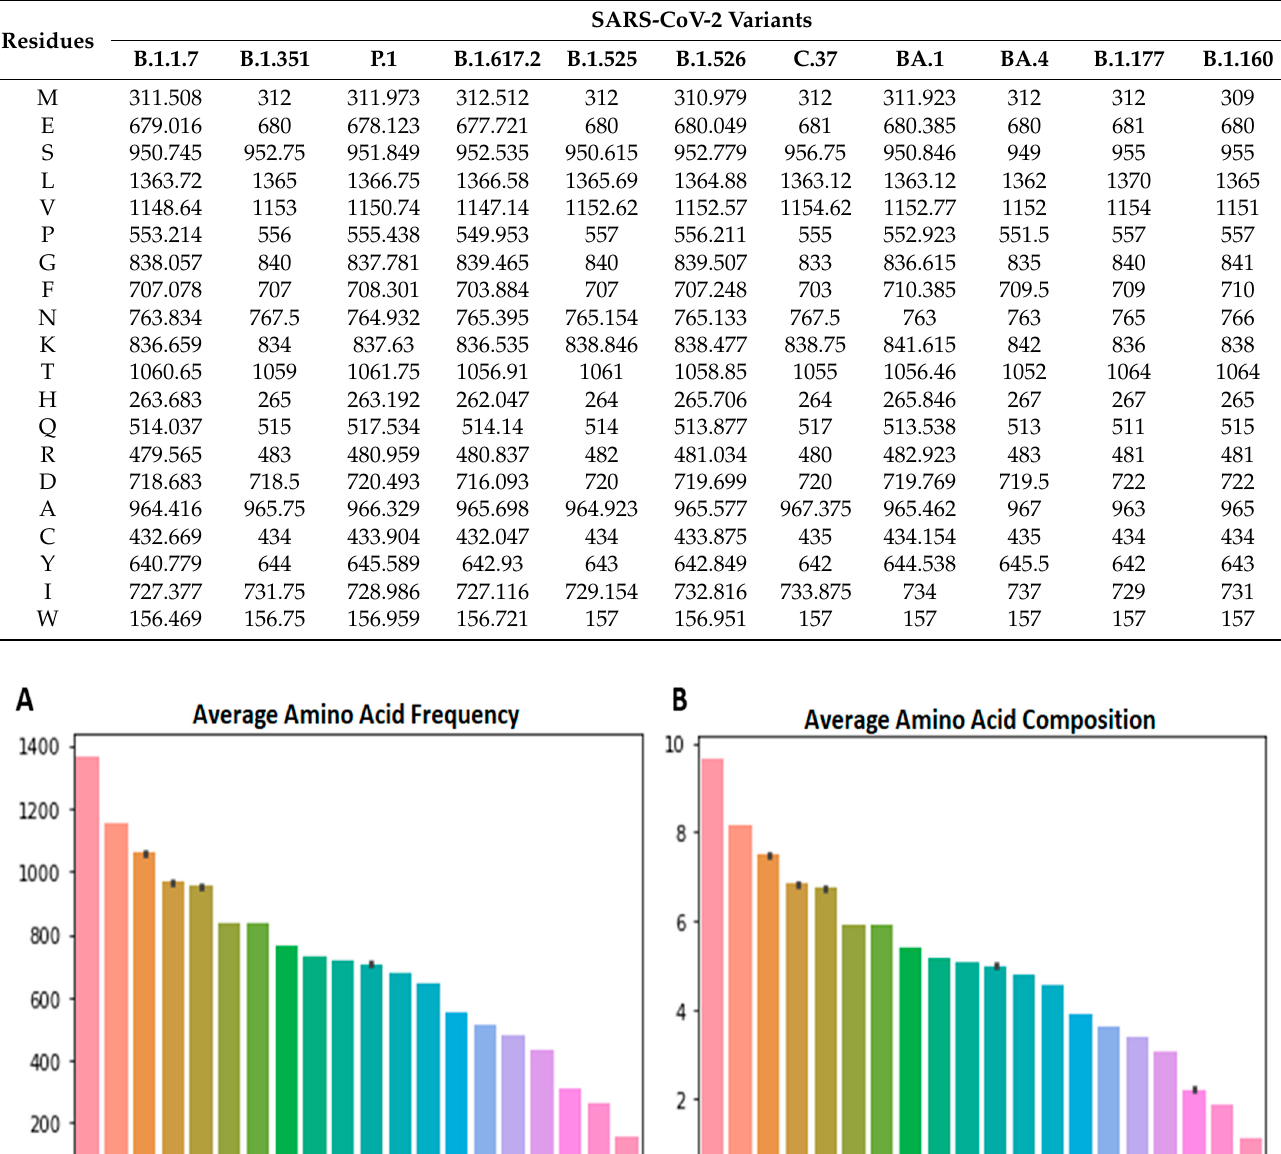
Table 2. Average amino acid count for each of the 11 lineages used in this study. The values presented here are rounded up to 3 decimal places.